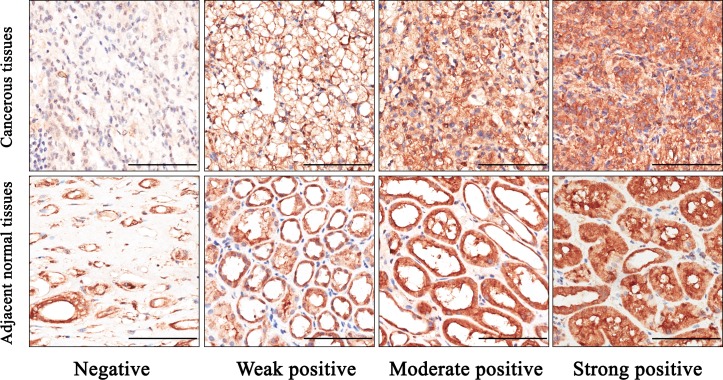
Representative immunohistochemical staining of SCD1 in ccRCC and adjacent normal tissues.A. Negative staining of SCD1 in ccRCC, score 0. B. Weak positive staining of SCD1 in ccRCC, score 3. C. Moderate positive staining of SCD1 in ccRCC, score 6. D. Strong positive staining of SCD1 in ccRCC, score 12. E. Negative staining of SCD1 in adjacent normal tissues, score 0. F. Weak positive staining of SCD1 in adjacent normal tissues, score 3. G. Moderate positive staining of SCD1 in adjacent normal tissues, score 6. H. Strong positive staining of SCD1 in adjacent normal tissues, score 12. Bar: 100 μm.